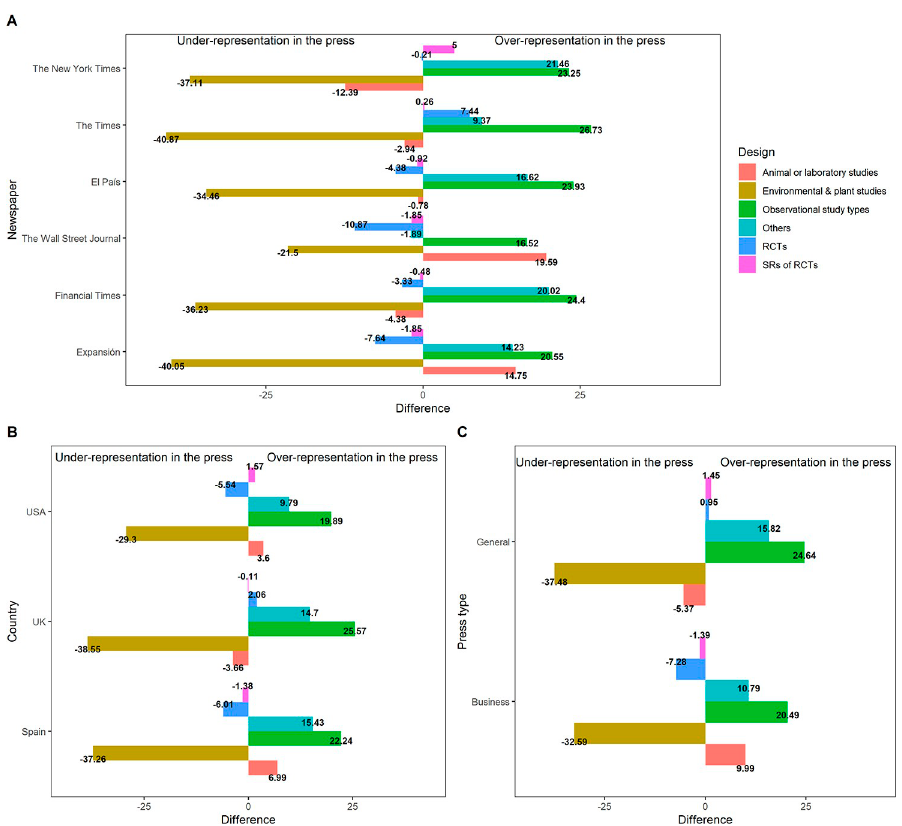
Fig 3. Over-representation and under-representation of microbiome study designs in the press vs PubMed.